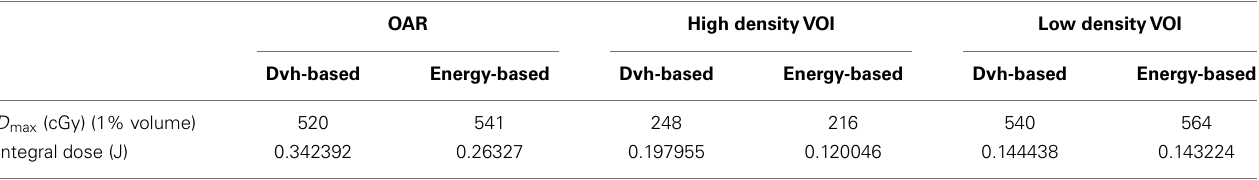
Table 1 | Integral doses and doses to 1% volumes of OAR, high density, and low densityVOIs .